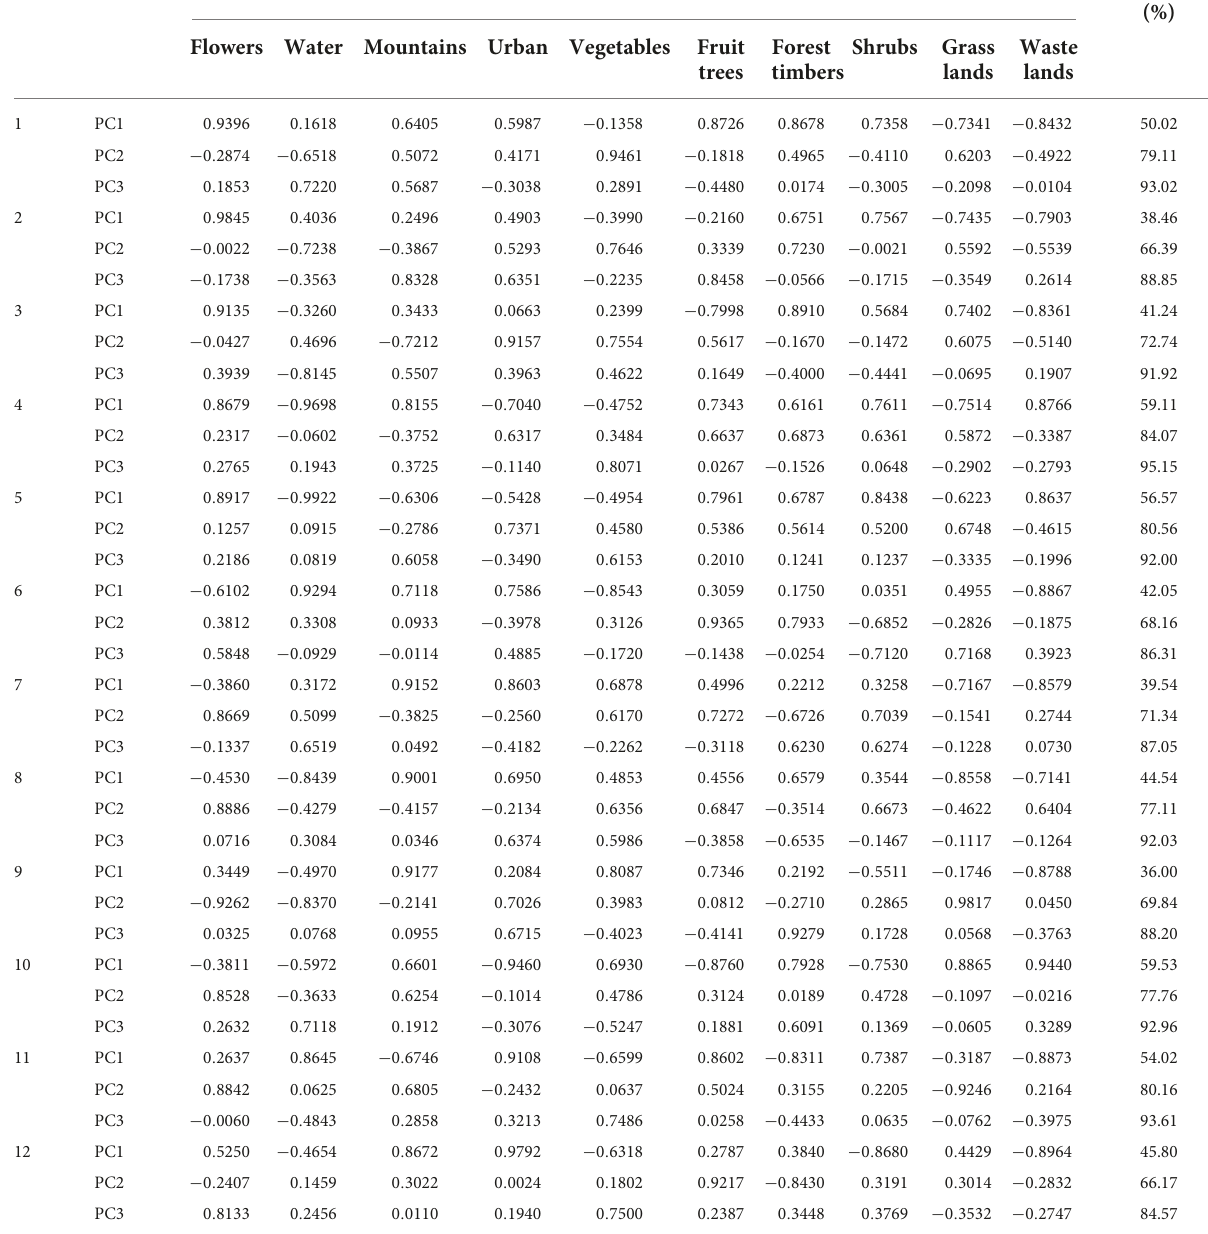
TABLE 3 Eigenvalues of the covariance matrix and cumulative proportion of principal components at each agriculture landscape in 2019. Land PC scapes